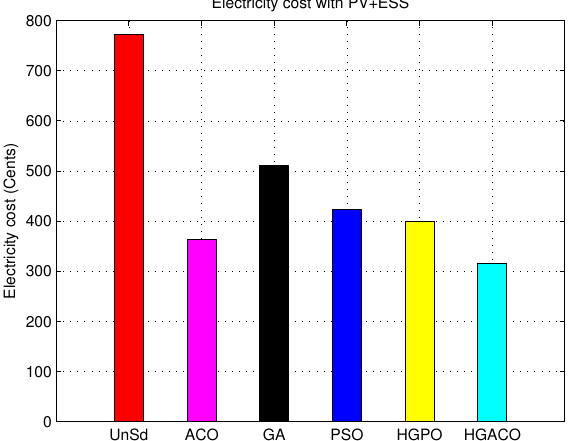
Figure 18. Aggregated electricity cost with photovoltaic-battery systems. Table 12. Scenario III: numerical results of electricity cost with photovoltaic-battery systems. Algorithms Cost (Cents)